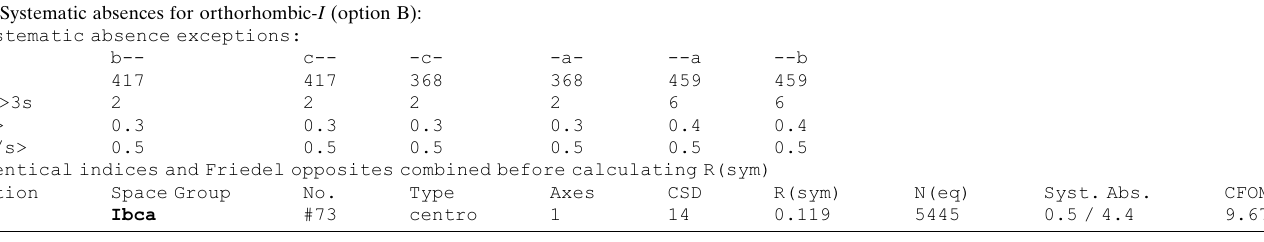
Table 5 Analysis of systematic absences for SAXDUR using XPREP . ( a ) For orthorhombic- I , systematic absences are consistent with space group Ibca . This setting, however, was abandoned because no viable structure could be obtained. ( b ) The lowest R sym monoclinic- I setting is consistent with either I 2/ a or Ia . ( a ) Systematic absences for orthorhombic- I (option B): Systematic absence